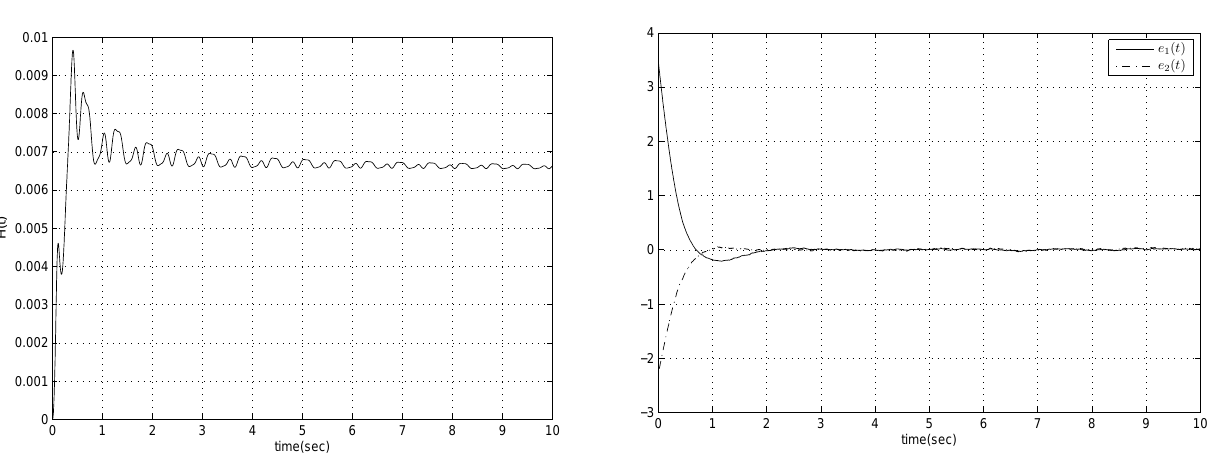
Fig. 1. The plot of H ( t ) versus time